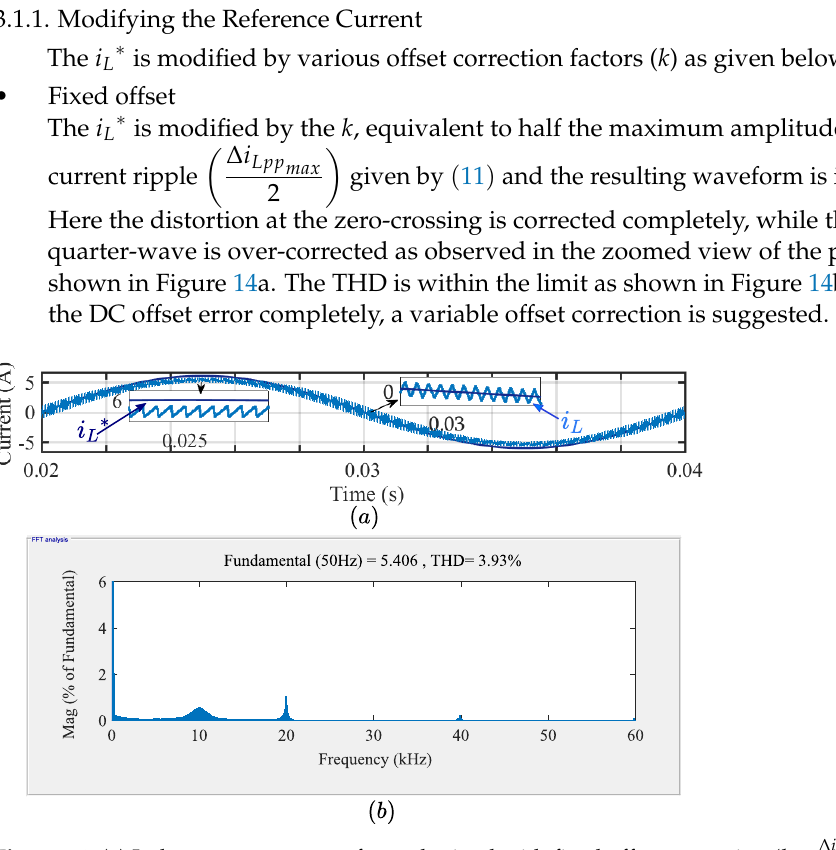
Figure 14. ( a ) Inductor current waveform obtained with fixed offset correction ( k = quency spectrum of inductor current obtained with fixed offset